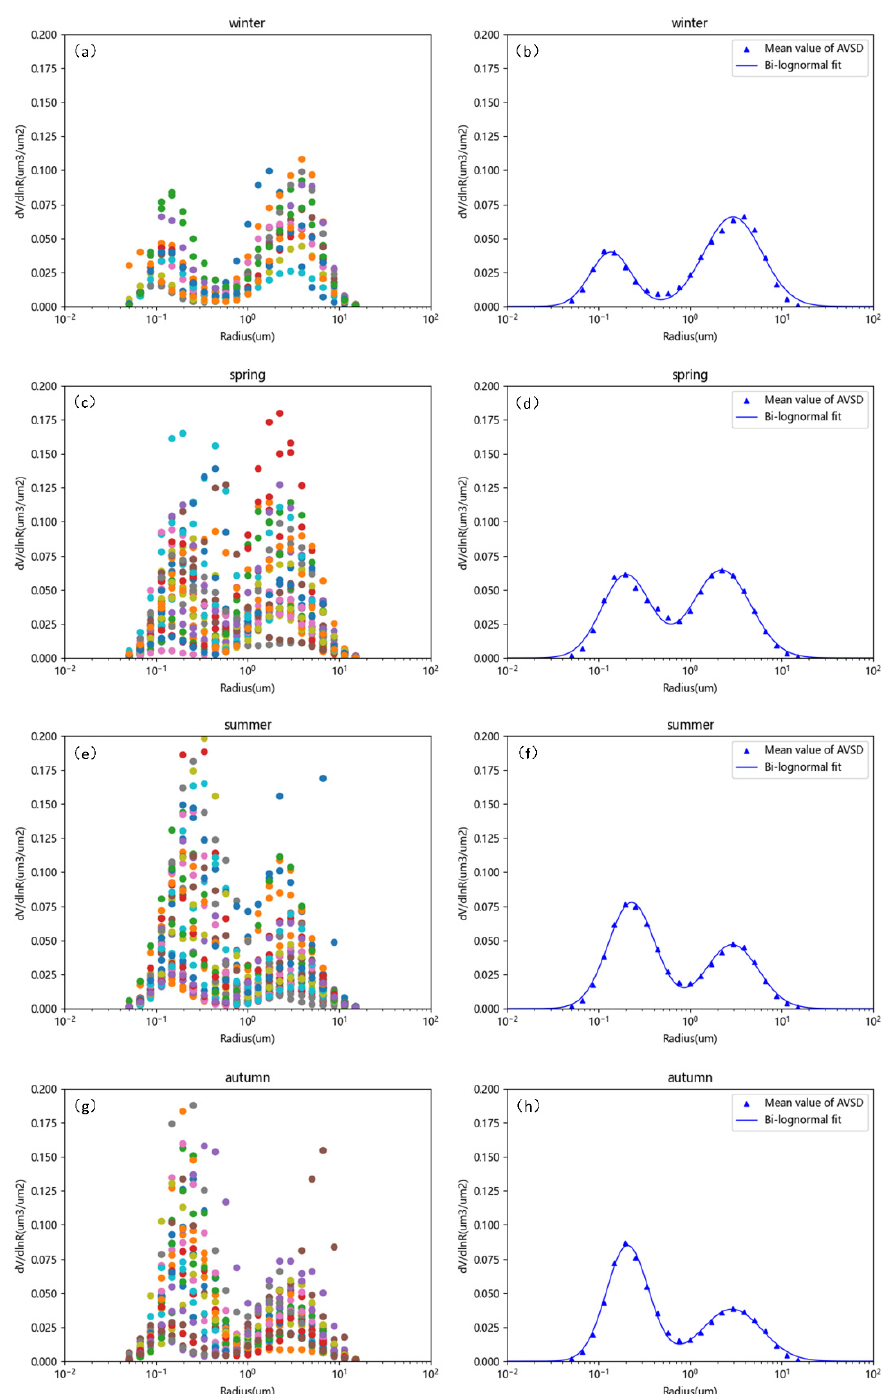
Figure 8. All columnar AVSD for each season under clean air conditions. ( a ) All columnar AVSD under clean air conditions in winter, with different colored dots representing columnar AVSD on different dates (same below); ( b ) blue triangles represent the mean values of all columnar AVSD under clean air conditions in winter, and the blue line represents the fitted curve of the mean columnar AVSD (same below); ( c ) all columnar AVSD under clean air conditions in spring; ( d ) mean values of all columnar AVSD under clean air conditions in spring; ( e ) all columnar AVSD under clean air conditions in summer; ( f ) mean values of all columnar AVSD under clean air conditions in summer; ( g ) all columnar AVSD under clean air conditions in autumn; ( h ) mean values of all columnar AVSD under clean air conditions in